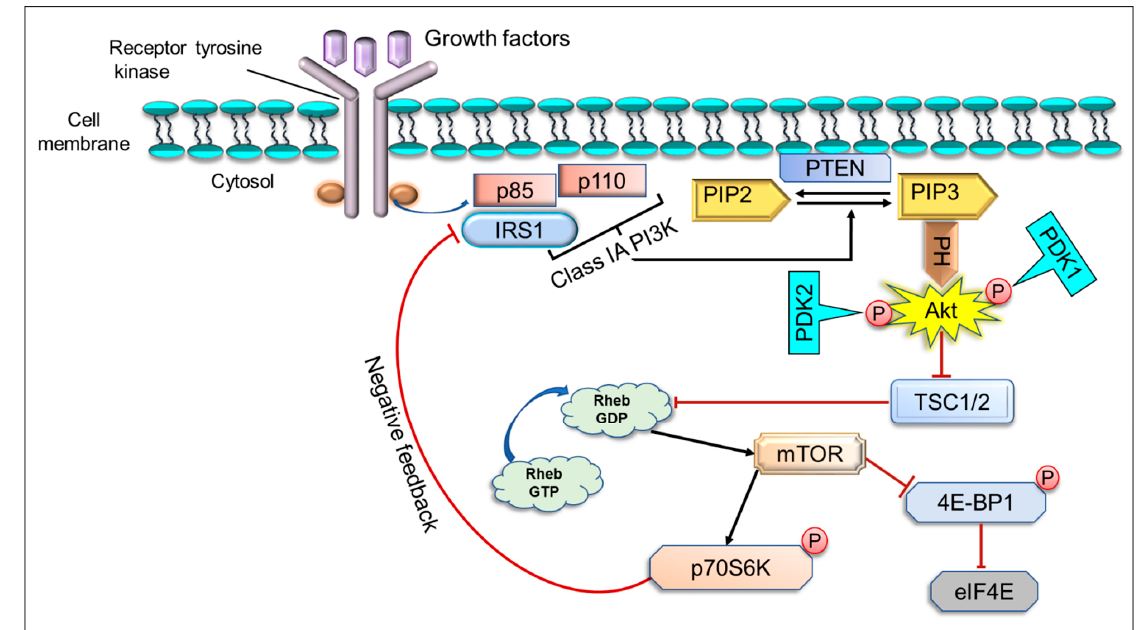
Figure 3. mTOR signaling cascade; IGF-1, insulin-like growth factor 1; EGF, epidermal growth factor; TGF, transforming growth factor; VEGF, vascular endothelial growth factor; PIP2, phosphatidylinositol 4, 5-bisphosphate; PDK1, 3-phospho- inositide-dependent kinase 1; TSC1/2, tuberous sclerosis complex 1/2; mTOR, mammalian target of rapamycin; PI3K, phos- phatidylinositol 3-kinase; eIF4E, eukaryotic translation initiation factor 4E; PTEN, phosphatase and tensin homolog de- leted on chromosome 10; IRS1, insulin receptor substrate 1; 4EBP1, eukaryotic translation initiation factor 4E-binding pro- tein 1; p70S6K1, p70 ribosomal S6 kinase 1; Rheb GDP, Ras homolog enriched in brain GDP; Rheb GTP, Ras homolog enriched in brain GTP.